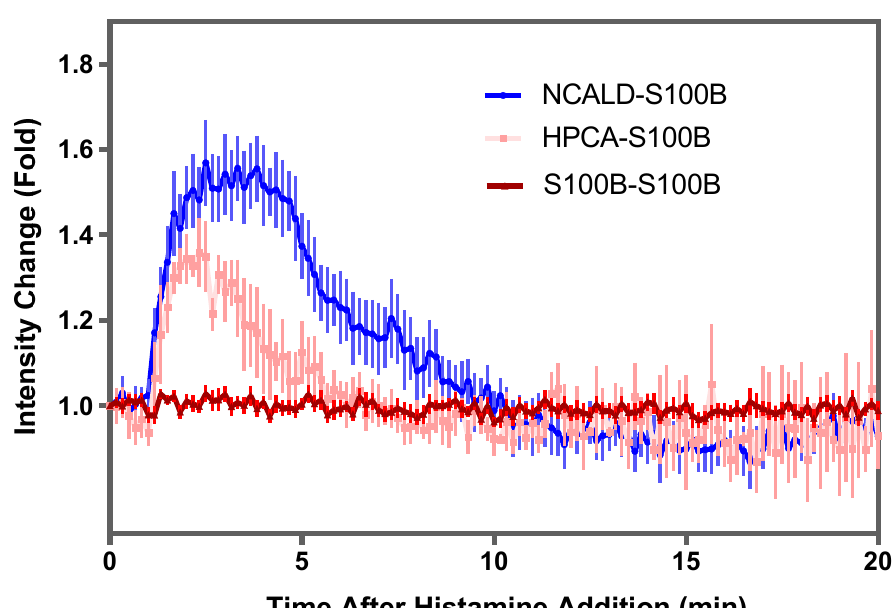
Figure 4. Translocation kinetics of S100B complexes—determination of a change in fluorescent intensities as a function of time: Readings from several experiments were averaged and the mean ± SEM is presented for the fold-change in fluorescent intensity observed in the trans-Golgi network (TGN) region for cells transfected with YN-NCALD and YC-S100B (NCALD-S100B, blue line, n = 20 cells); YN-HPCA and YC-S100B (HPCA-S100B, pink lines, n = 10 cells) and YN-S100B and YC-S100B (S100B-S100B, red line, n = 20 cells). At least three independent transfections were used to collect the data.